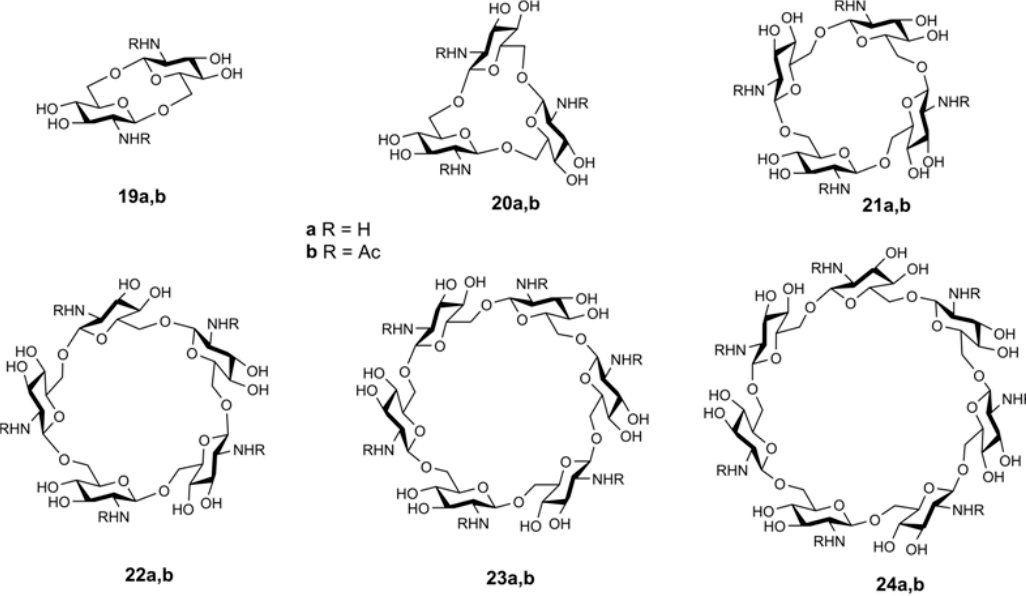
Figure 16. Structural formulas of cyclooligo- β -(1 → 6)- D -glucosamines 19a – 24a and cyclooligo- β -(1 → 6)- D - N -acetylglucosamines 19b – 24b [70,72–74] (reproduced from [70] with permission of Springer Nature).